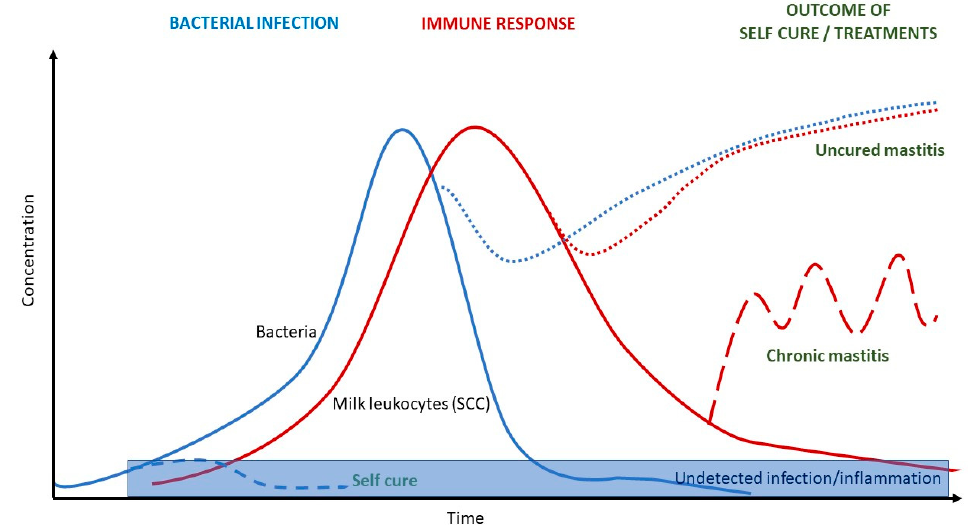
Figure 1. Dynamics of intramammary bacterial infection and udder inflammatory response. The figure models the concentration trend (Y axis) over time of mastitis pathogens and of the leukocytes, hypothesizing different outcomes (cured, uncured, chromicized mastitis), from [15] .